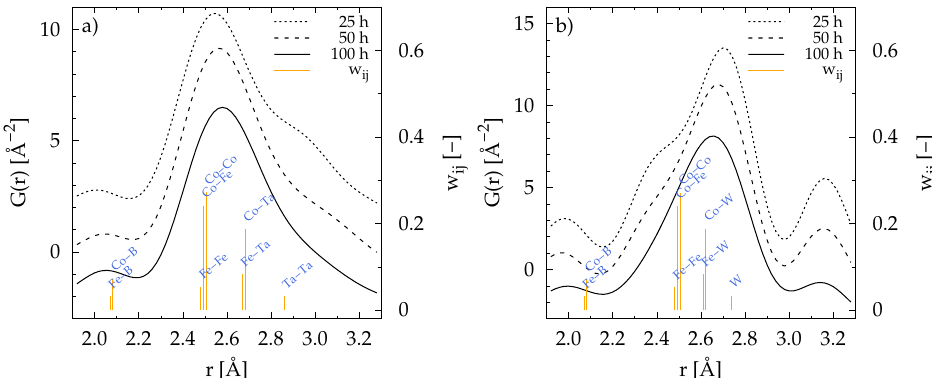
Figure 7. Detailed view of the first coordination sphere, as seen from the total pair distribution function G ( r ) for ( a ) CoFeTaB alloy and ( b ) CoFeWB alloy after 25, 50 and 100h of mechanical alloying. For a better clarity, curves are vertically offset. Positions and heights of the vertical lines denote bond lengths r ij of atomic pairs and X-ray weighting factors w ij ,